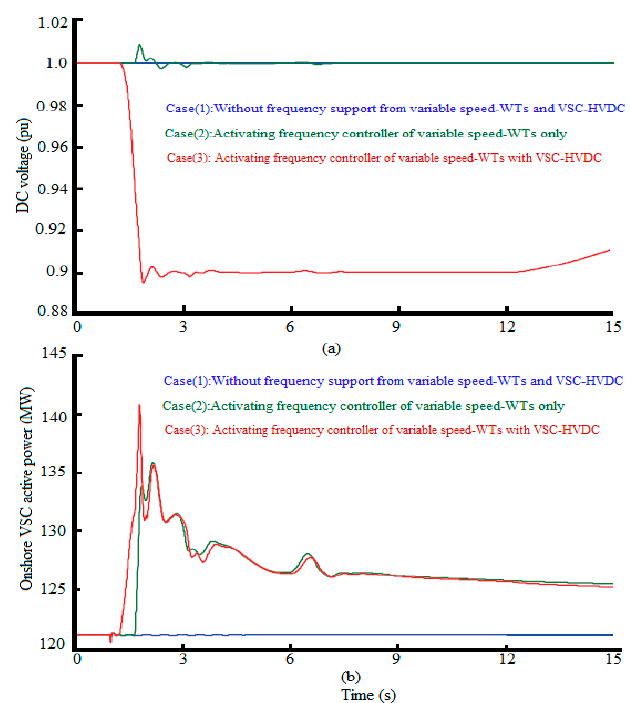
Figure 24. Effect of the VSC-HVDC frequency regulation in the three cases for; ( a ) DC link voltage; and ( b ) onshore VSC active power production.